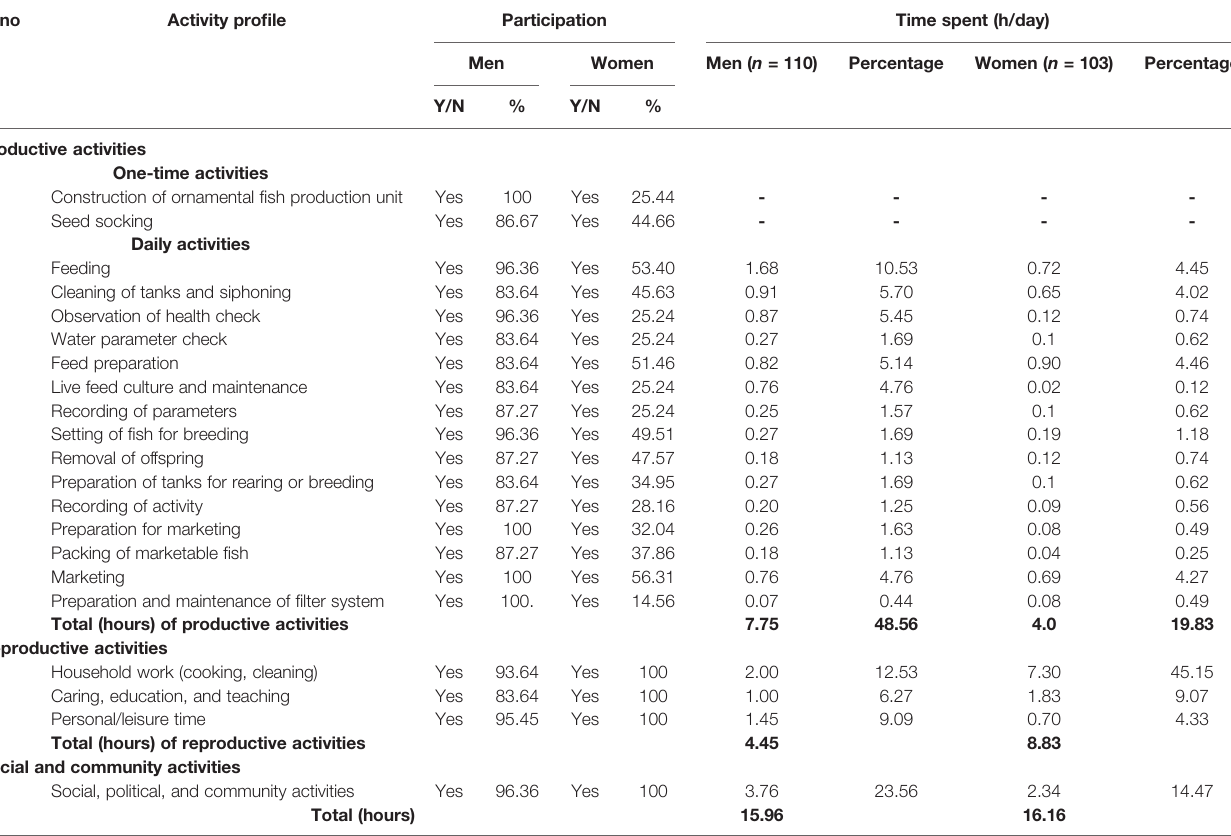
TABLE 1 | Participation and time spent (h/day) by men and women in productive activities, reproductive activities, and social and community activities. S.